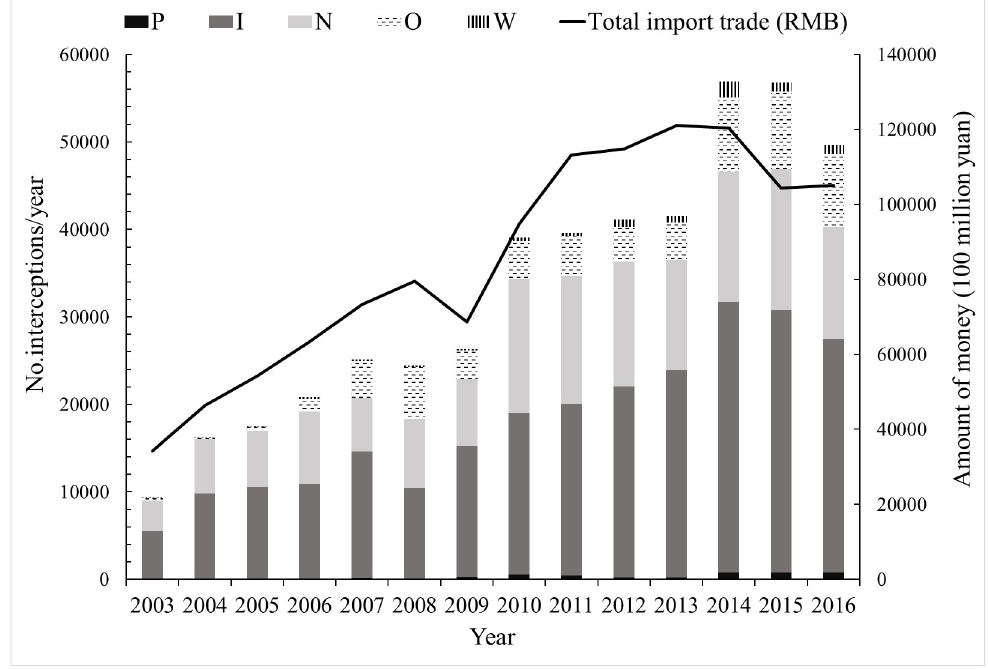
Fig 1. Number of intercepted pests and total import trade from 2003 to 2016. I = Insects, N = Nematodes, W = Weeds, P = Pathogens, O = Others (e.g. mites, spiders, mollusks).